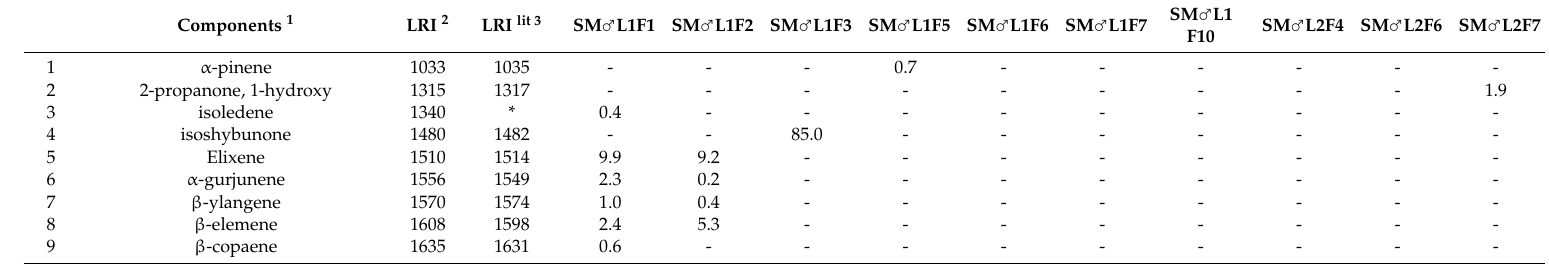
Table 4. Chemical composition (%) of petroleum ether and diethyl ether fractions from male S. molle (L.)